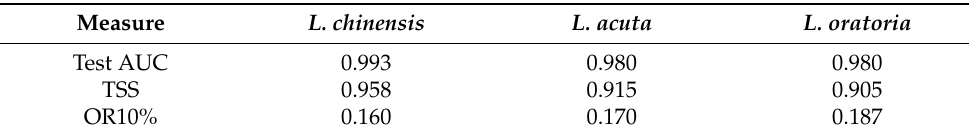
Table 2. Measures of the models for three Leptocorisa